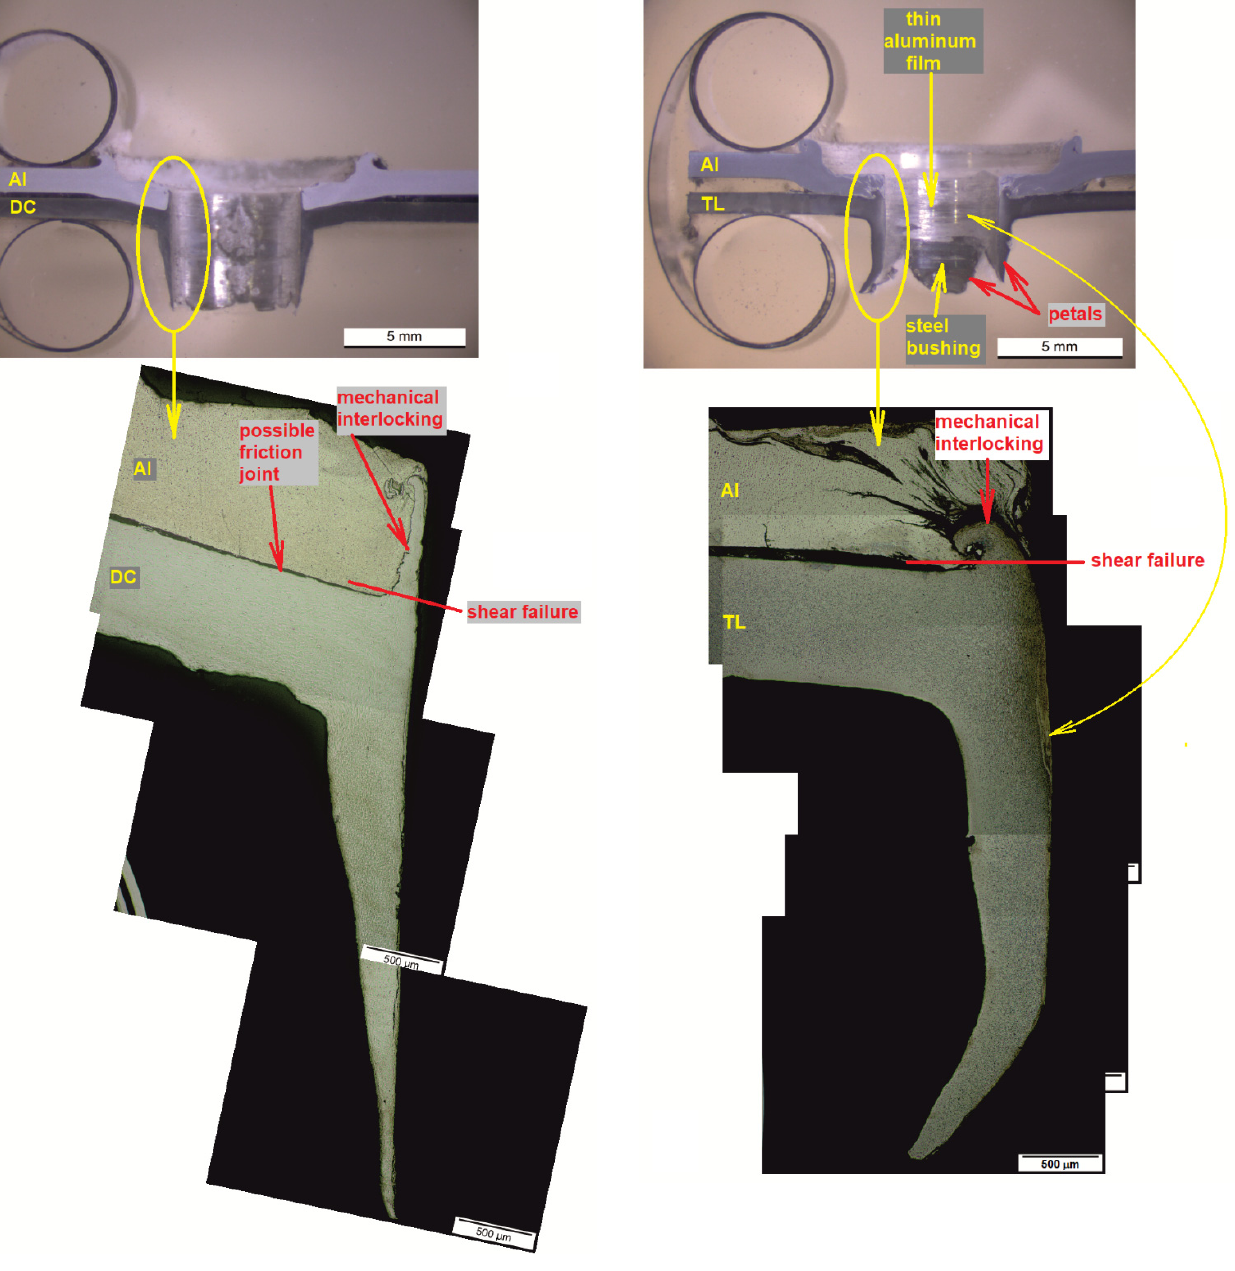
Figure 4. Cross sections of Al-DC and Al-TL joints, etched: Nital,